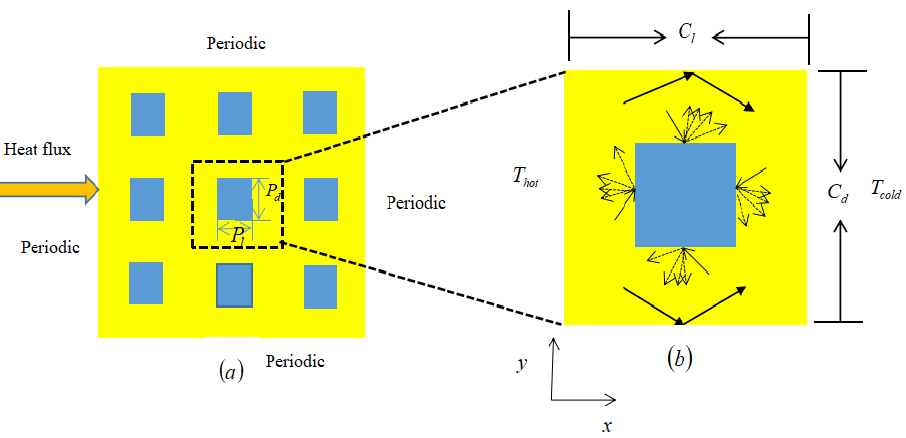
Figure 1. The sketch for nanoporous phononic crystals. ( a ) In-plane heat flux view. ( b ) Geometric model for the unit cell of heat flux under in-plane condition.